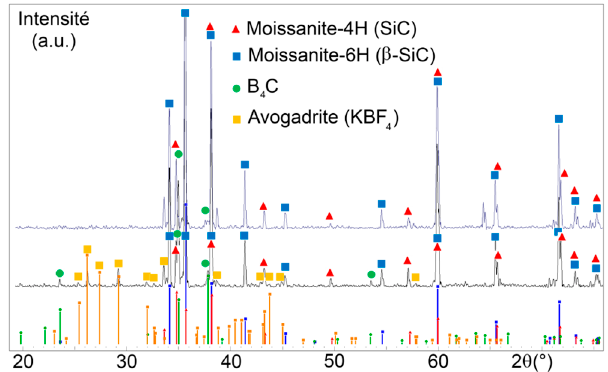
Figure 1. Phase identification in the fresh and used pack powder. Bottom: theoretical rays; Middle: fresh powder; Top: used powder.